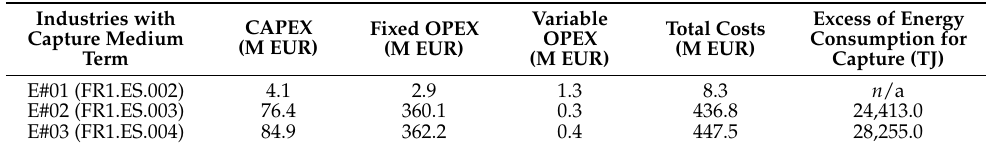
Table 4. Summary of CAPEX, OPEX and Energy consumption of CCUS for the three selected emitters of the Paris Basin